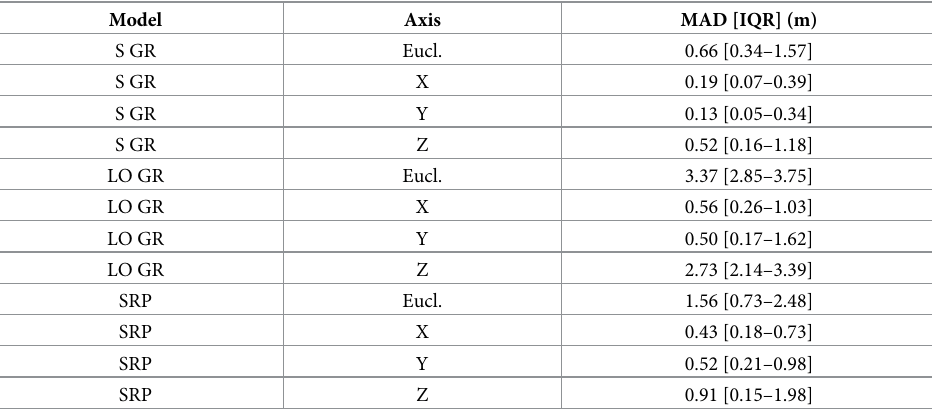
Table 5. MAD and IQR of test set source coordinate